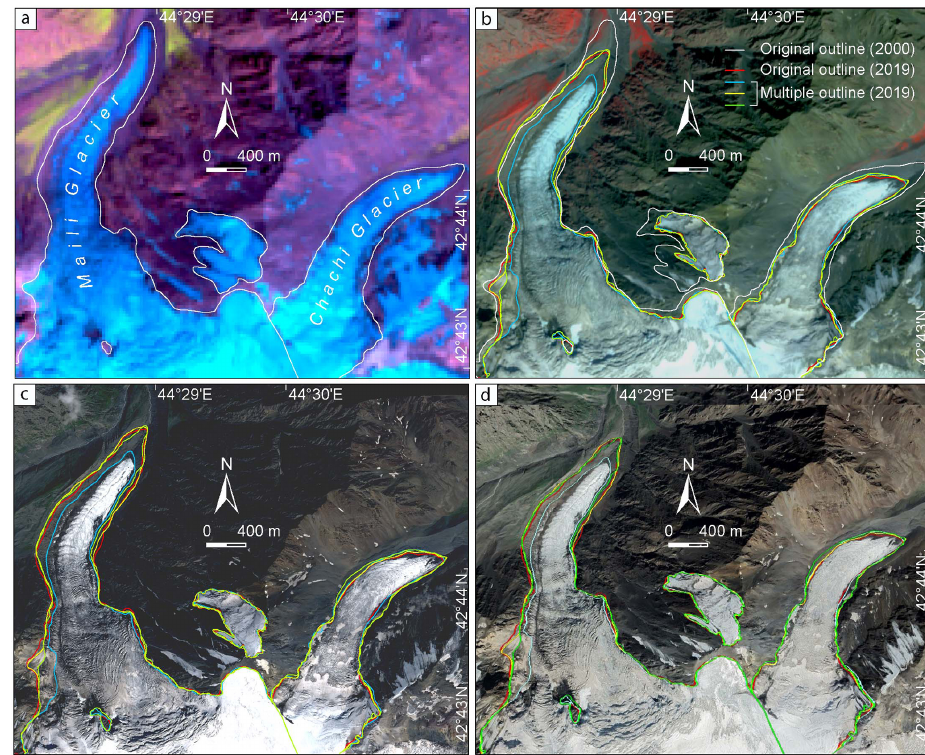
Figure 2. (a) Three glaciers shown on the Landsat scene (28 July 2000), which were later selected for multiple digitizing. An example of multiple digitizing based on the imagery from the same year – (b) Sentinel-2 23 August 2019, (c) SPOT 13 August 2019, and (d) Google Earth 14 September 2019. Image credits: (a) https://earthexplorer.usgs.gov (last access: November 2020), (b) Copernicus Sentinel data 2019, (c) Azercosmos satellite data, (d) © Google Earth